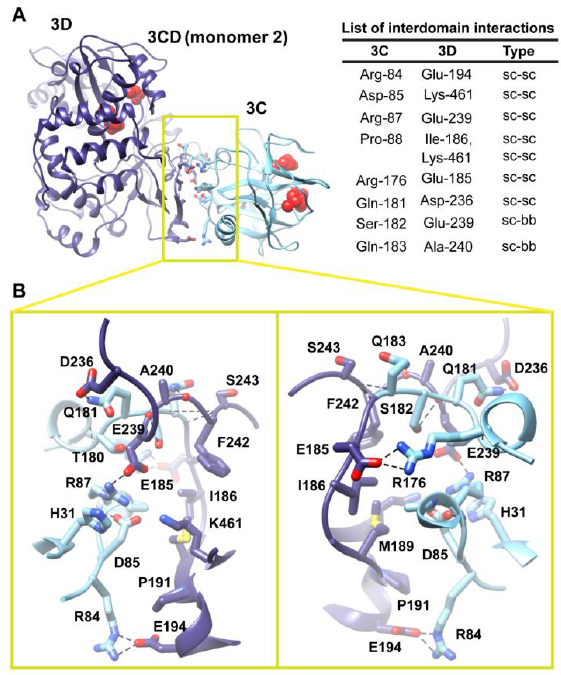
Figure 6. Interface in the compact conformation of 3CD (monomer 2). ( A ) The simulated 3CD is shown with interface residues displayed as sticks; the 3C and 3D domains are colored cyan and blue; respectively. The active-site residues of the protease (His-40, Glu-71, Cys-147) and polymerase (Asp-